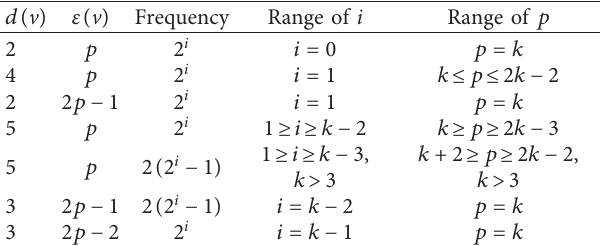
Table 3: Vertices partition of an X -tree ( k -level) based on degree and eccentricity of each vertex with the existence of its